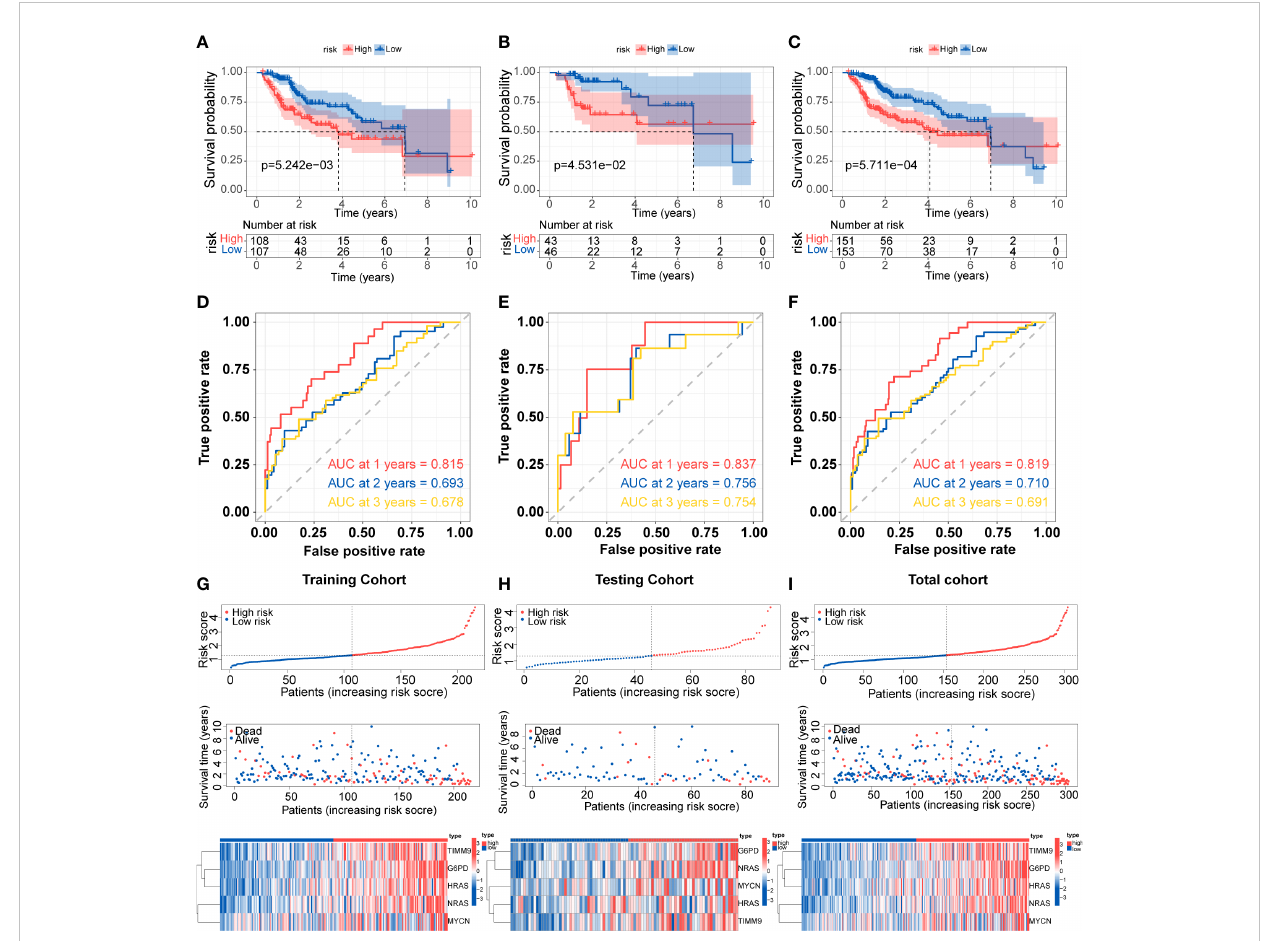
FIGURE 3 Development and validation of the prognostic signature (A-C) Kaplan-Meier survival for overall survival in the two subgroups for the training cohort, testing cohort, and total cohort. (D-F) ROC curve evaluated the prognostic value of the risk model in the training cohort, testing cohort, and total cohort. (G-I) Distribution of risk score, correlation between the survival time and survival status of each patient, and the heatmaps of this signature expressions in the training cohort, testing cohort, and total